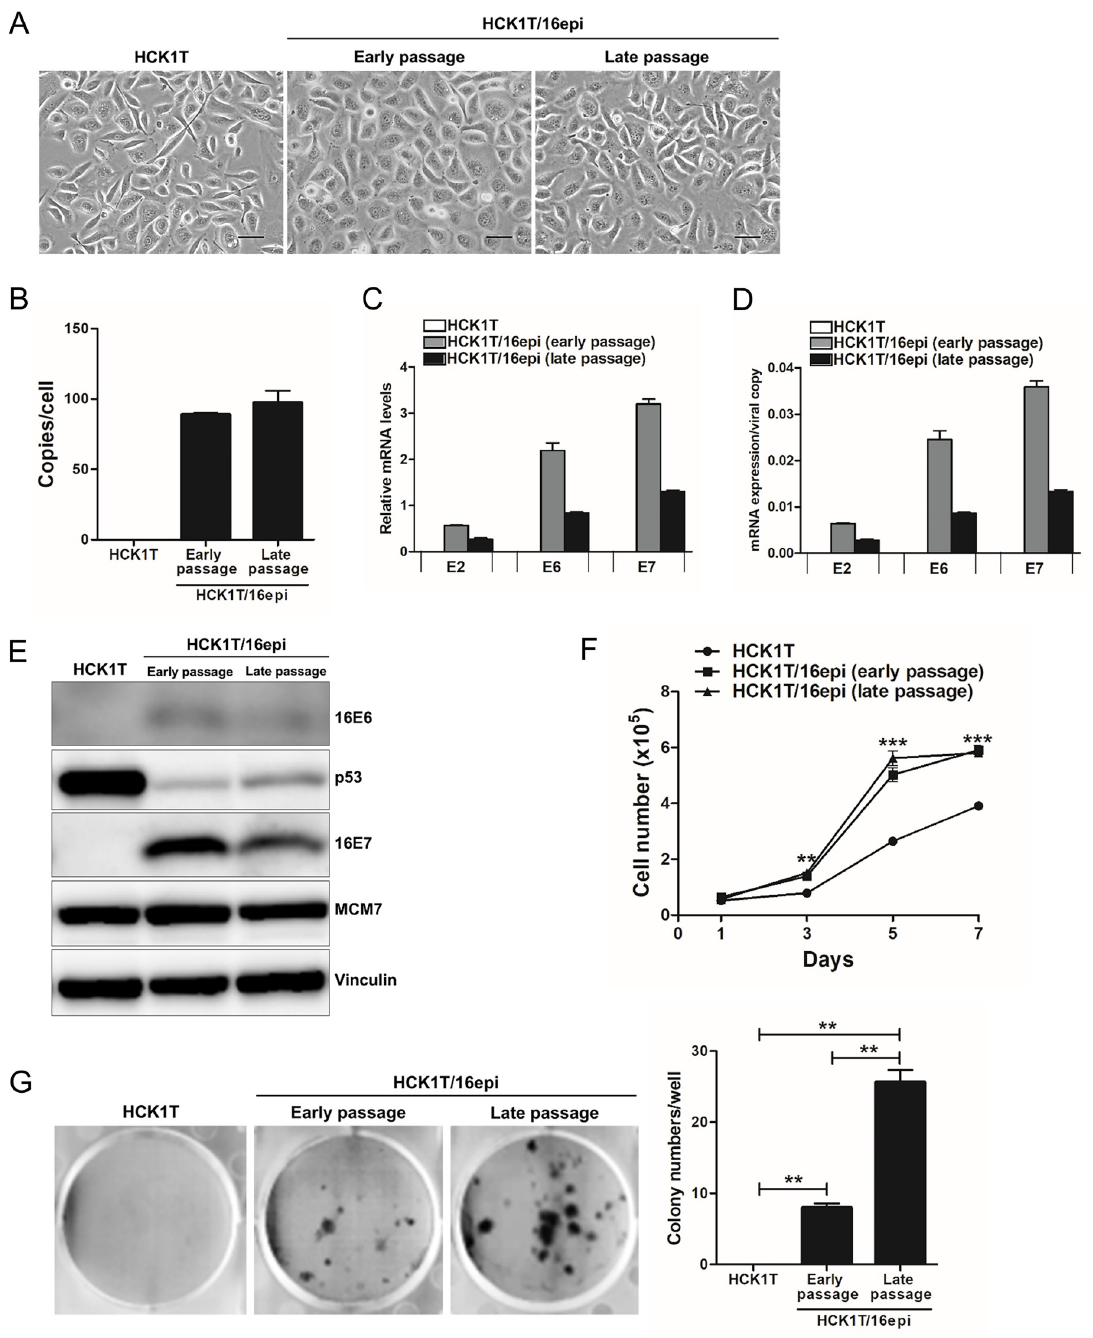
Fig 1. Characterization of the HCK1T cells harboring episomal form of HPV16 genome. ( A ) Cell morphology of HCK1T/HPV16epi at early and late passage was compared to parental HCK1T cells. Scale bars represent 50 μ m. ( B ) The copy number of HPV16 was measured by quantitative PCR using specific primers to the E6 and L2 ORFs of HPV16. Relative expression levels of HPV16 E6 and E7 mRNA in HCK1T/16epi, showing levels overall ( C ) and per viral copy, calculated using the following formula: Mean relative mRNA expression/mean relative HPV16 copy number ( D ). ( E ) Expression of HPV16 E6 and E7 oncoproteins was detected by western blotting using specific anti-HPV16 E6 and E7 antibodies and the levels of E6 and E7 were compared between early- and late-passage HCK1T/ 16epi cells. Parental HCK1T cells were included as a negative control. Levels of p53 and MCM7 proteins were also determined to show that E6 and E7 from episomal HPV16 genomes are able to reduce p53 or increase MCM7, a robust indicator of E7 activity [31], respectively. Vinculin was included as a loading control. The ability of the episomal form of HPV16 to promote cell transformation in HCK1T/16epi cells relative to the parental HCK1T cell line was demonstrated by examining growth curves and clonogenic potential. ( F )